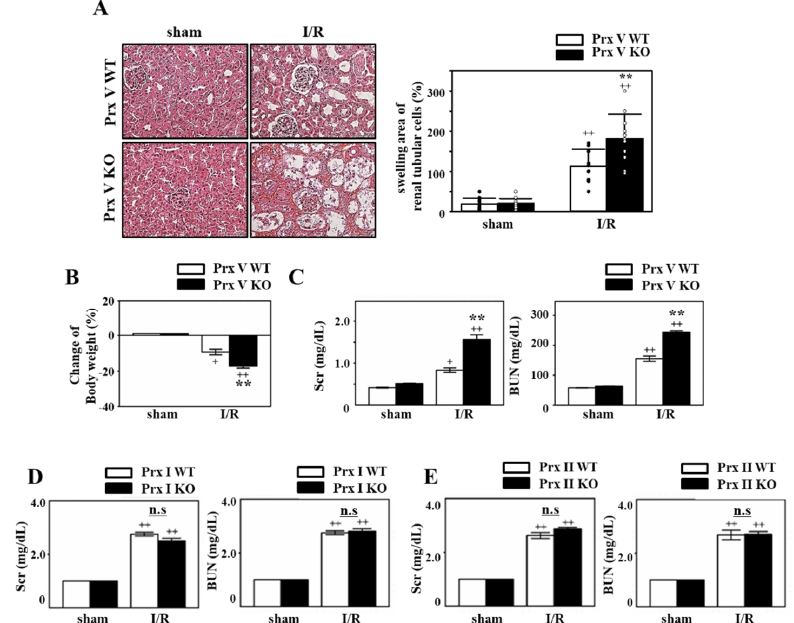
Figure 2. Effect of Prx V ablation on renal structure and function during renal I/R. Prx V WT and KO Figure 2. E ff ect of Prx V ablation on renal structure and function during renal I / R. Prx V WT and KO male mice were subjected to renal ischemia for 30 min followed by up to three days of reperfusion or sham surgery. ( A ) The kidney sections were subjected to H&E staining. Original magnification, 400 × . Quantification of the swelling area of the renal tubular cells. NIS-Elements AR 3.1 software was used to quantify. ( B ) Changes of body weight were measured before sacrificed. ( C ) BUN and Scr concentrations were measured from serum of the mice. Prx I ( D ) or II ( E ) WT or KO mice were subjected to renal ischemia for 30 min followed by up to 3 days of reperfusion or sham surgery. BUN and Scr concentrations were measured from serum of the mice. Data are shown as means ± SE. n = 5–6 / group, ** p < 0.01 vs. WT, + p < 0.05 vs. sham, ++ p < 0.01 vs. sham, not significant;